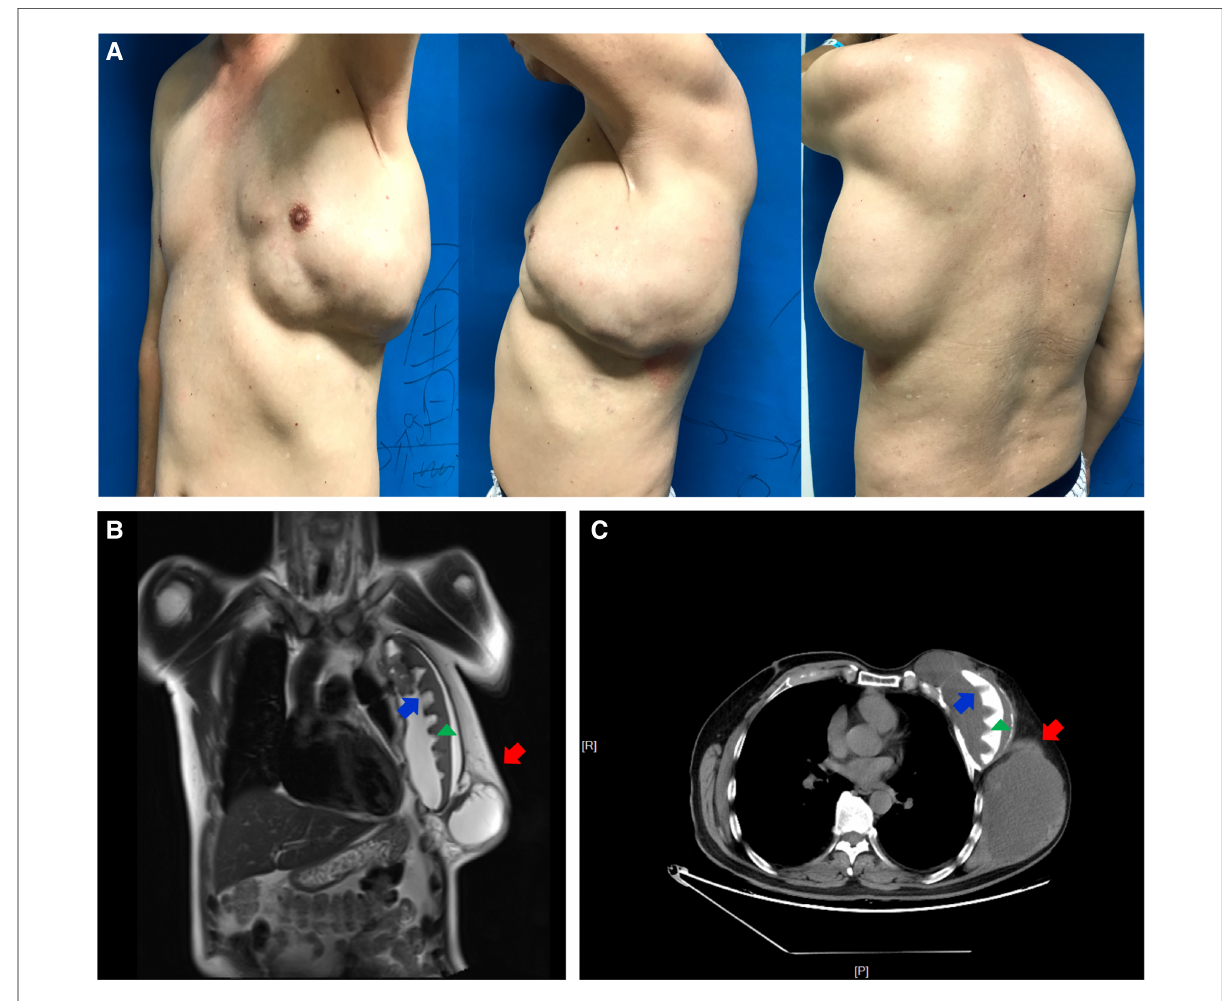
FIGURE 1 Physical examination and imaging studies of the patient. A large-sized multinodular mass was on the left chest of a 52-year-old man with a breast implant for past 19 years ( A ). MRI ( B ) and CT ( C ) fi ndings showed a 20-cm sized polycystic mass (red arrow) in front of the implant (green triangle) and multiple irregular masses (blue arrow) in front of the ribs posterior to the